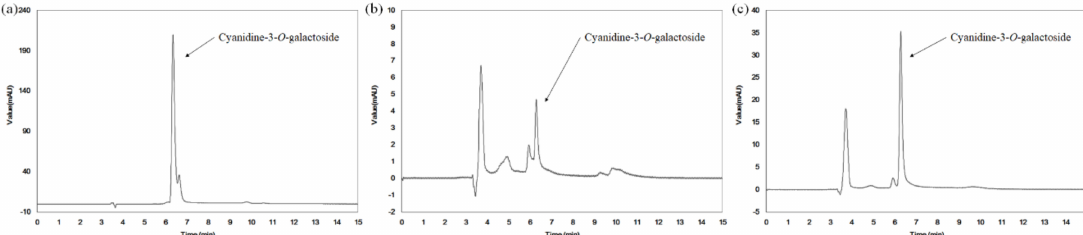
Figure 3. Comparison of High-Pressure Liquid Chromatography (HPLC) chromatograms of C3G in the extract from three different extraction conditions: ( a ) standard C3G, ( b ) conventional extraction by a juice extractor, and ( c ) optimal extraction condition.